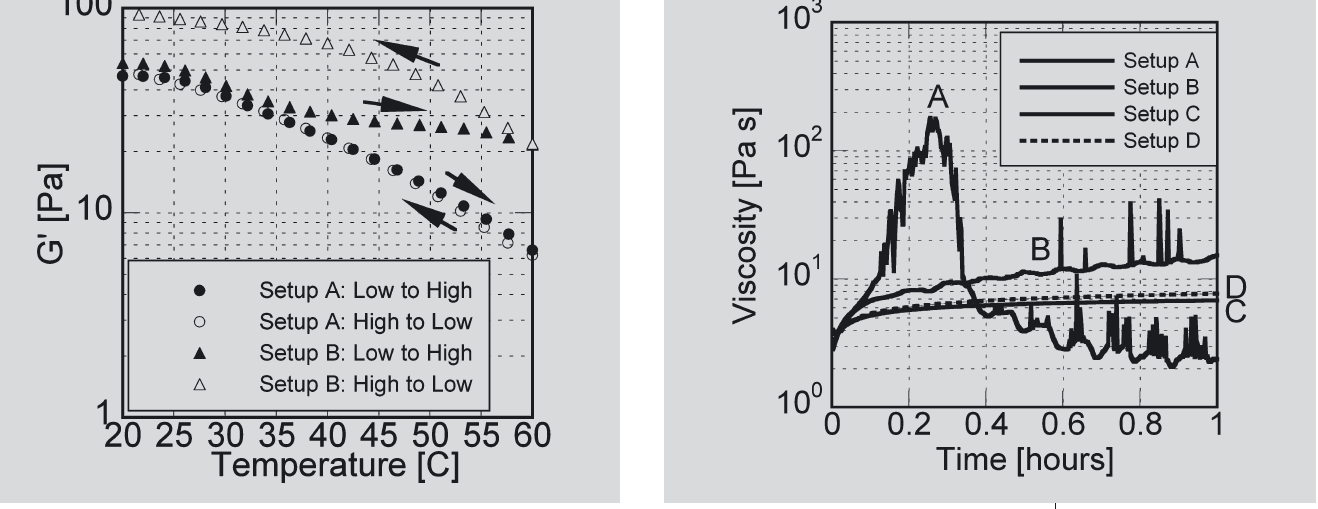
Figure 3 (left): Gel strength of block copolypeptide hydrogel during temperature sweep. Figure 4: Transient viscosity of col- loidal aqueous suspensions of precipitated calcium car- bonate at 1 s -1 in different sample chamber configura- tions (see Table